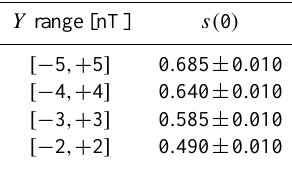
Table 1. Scaling exponents s( 0 ) versus Y range.